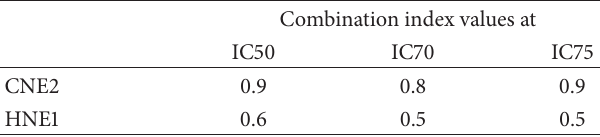
Table 1: The combination indexes (CIs) of cetuximab and cisplatin in CNE2 and HNE1